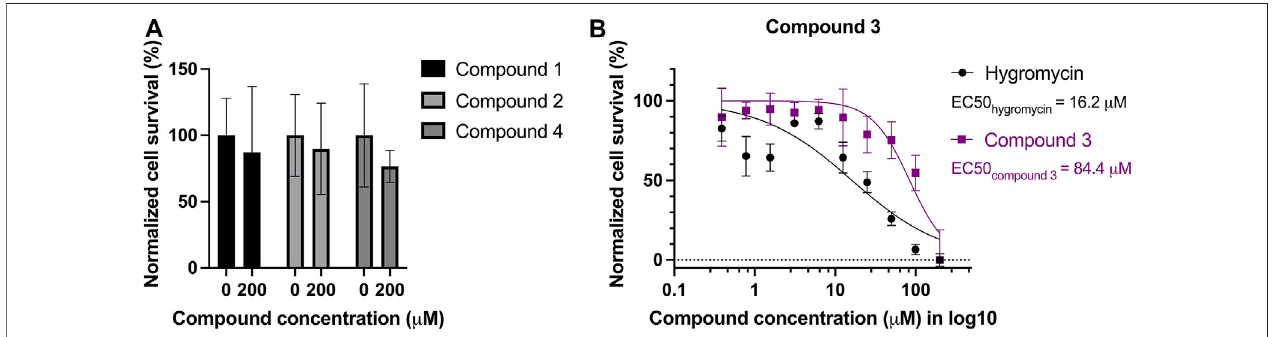
FIGURE 6 | Cytotoxicity test of the four compounds on HepG2 cells. Mammalian cell line HepG2 was treated with serial dilutions of the four compounds: (A) compound 1 , 2 , and 4 led to minor reduction of the survival rate, ranging from 75% to 90% at 200 μ M, in comparison to the survival rate without treatment. (B) Compound 3 is toxic to HepG2 with an EC50 of 84.4 µM. Hygromycin was used as a control for an active drug, and it has an EC50 of 16.2